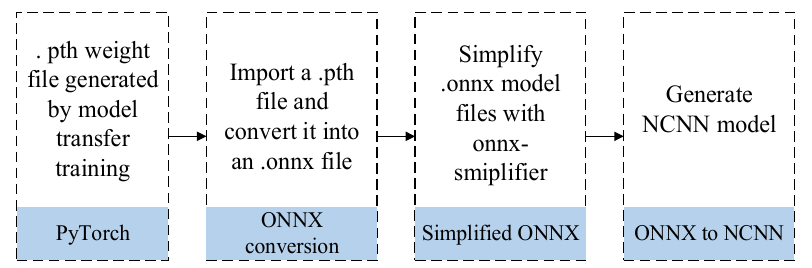
Figure 6. Model transformation process.